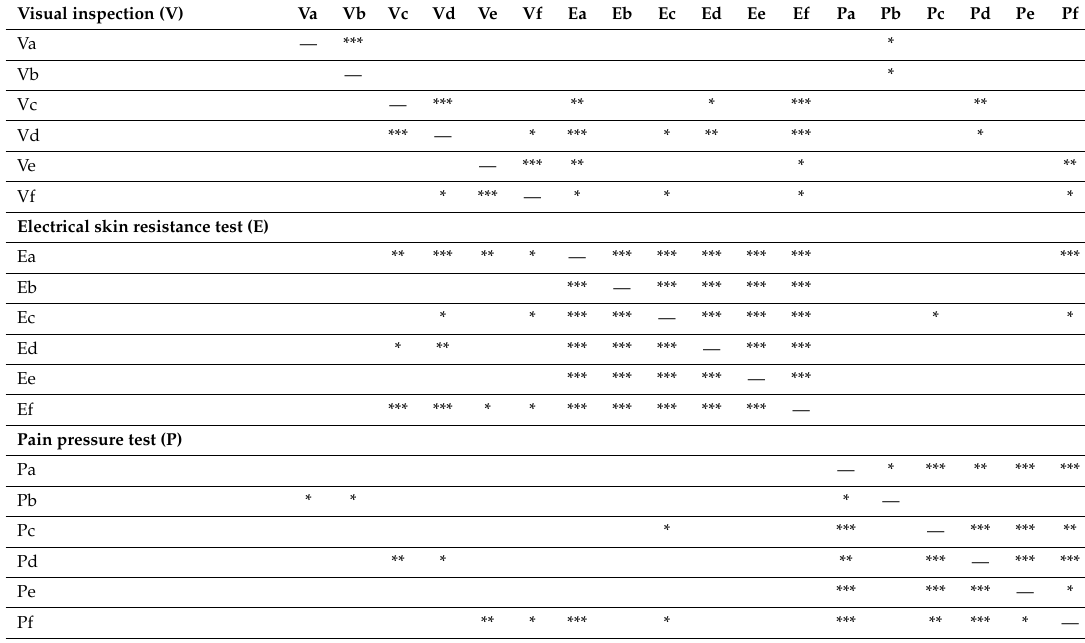
Table 4. Association between auricular signals under testing # ( n =